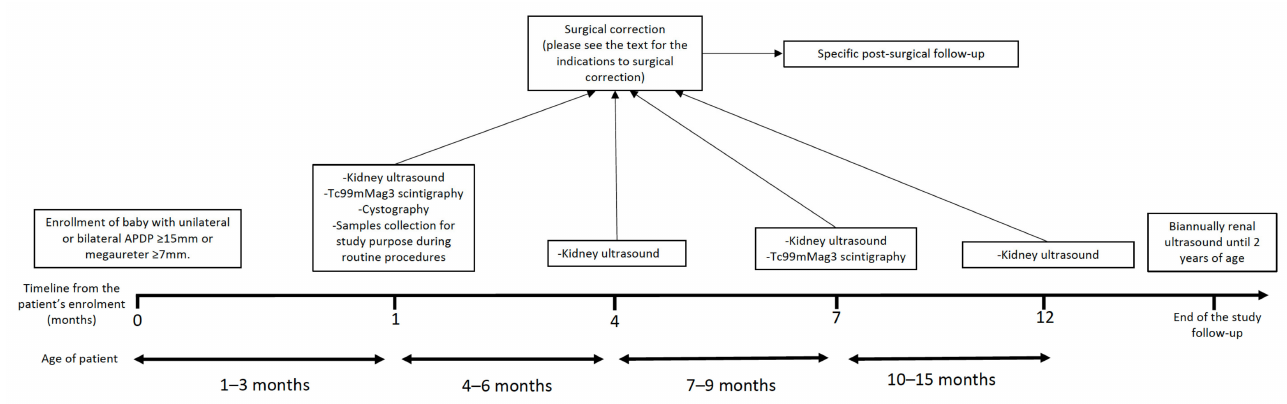
Figure 1. Protocol of the